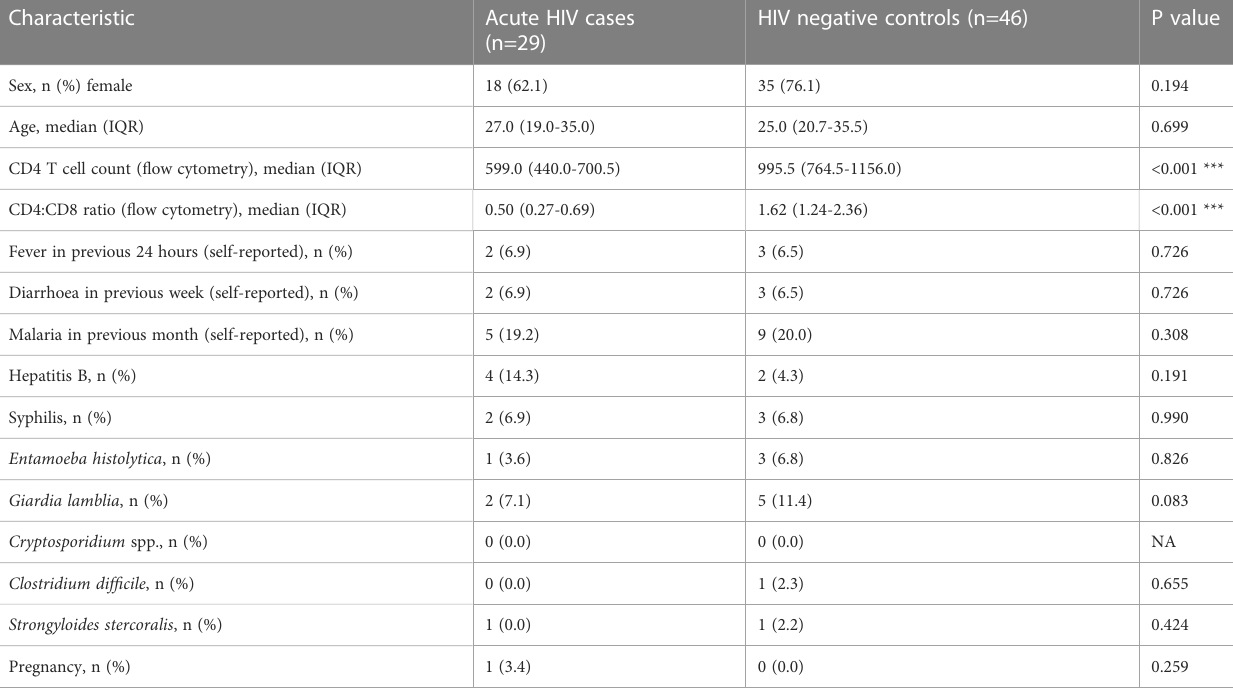
TABLE 1 Characteristics of study population one month from presentation.